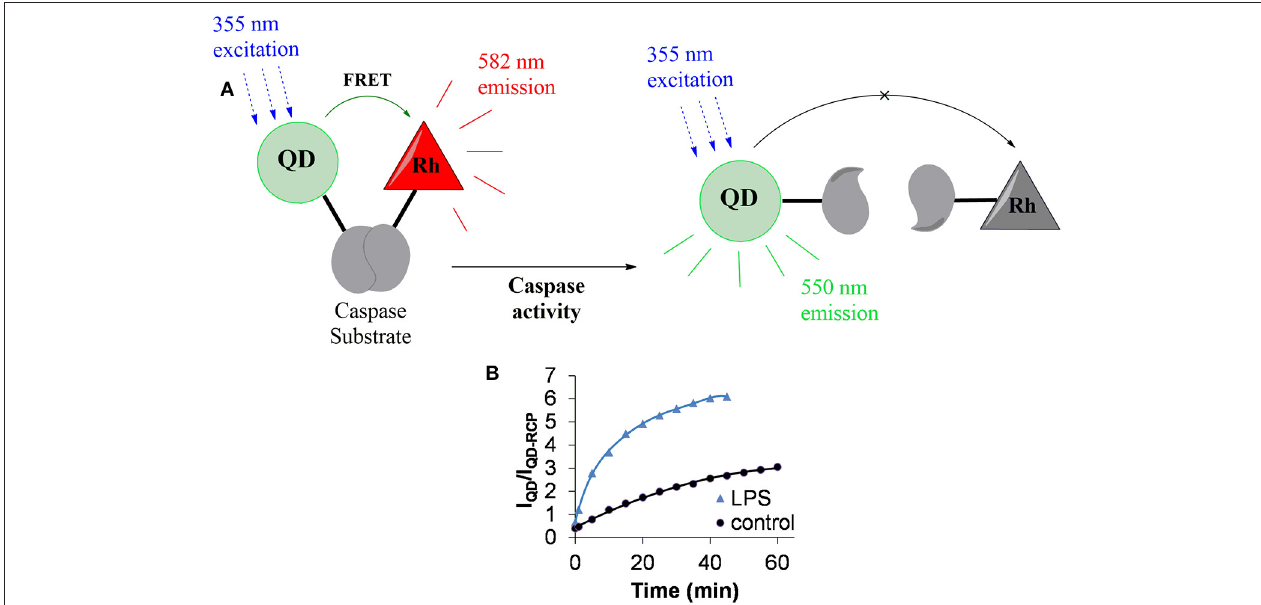
FIGURE 4 | QD-based nanosensor for the detection of caspase-1 activity. (A) In the absence of caspase activity, FRET between the quantum dot (QD) and rhodamine (Rh) results in the latter’s fluorescence emission at 582nm (shown in red). Active caspase cleaves the substrate peptide linking the QD and rhodamine and FRET is abolished. This results in the loss of Rh fluorescence and the gain of QD emission (shown in green). (B) Representative measures of caspase-1 sensor activity using QD-based sensor. LPS induces caspase activation which leads to rapid cleavage of the peptide link between QD and Rh an increase in the fluorescence ratio of I QD (550nm)/I QD - RCP (582nm). RCP, Rhodamine conjugated peptide.